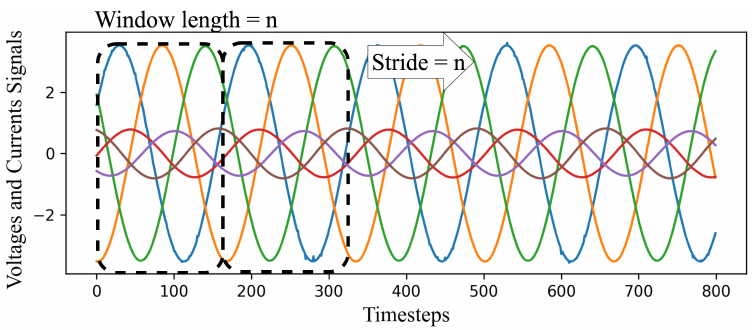
Figure 3. Sliding window approach.